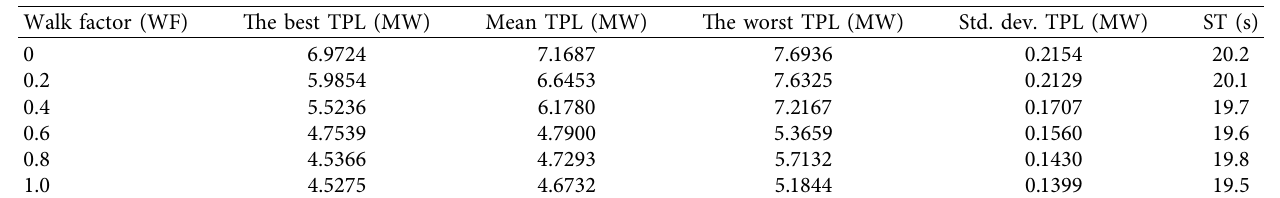
� 10 and MI � 200. pop